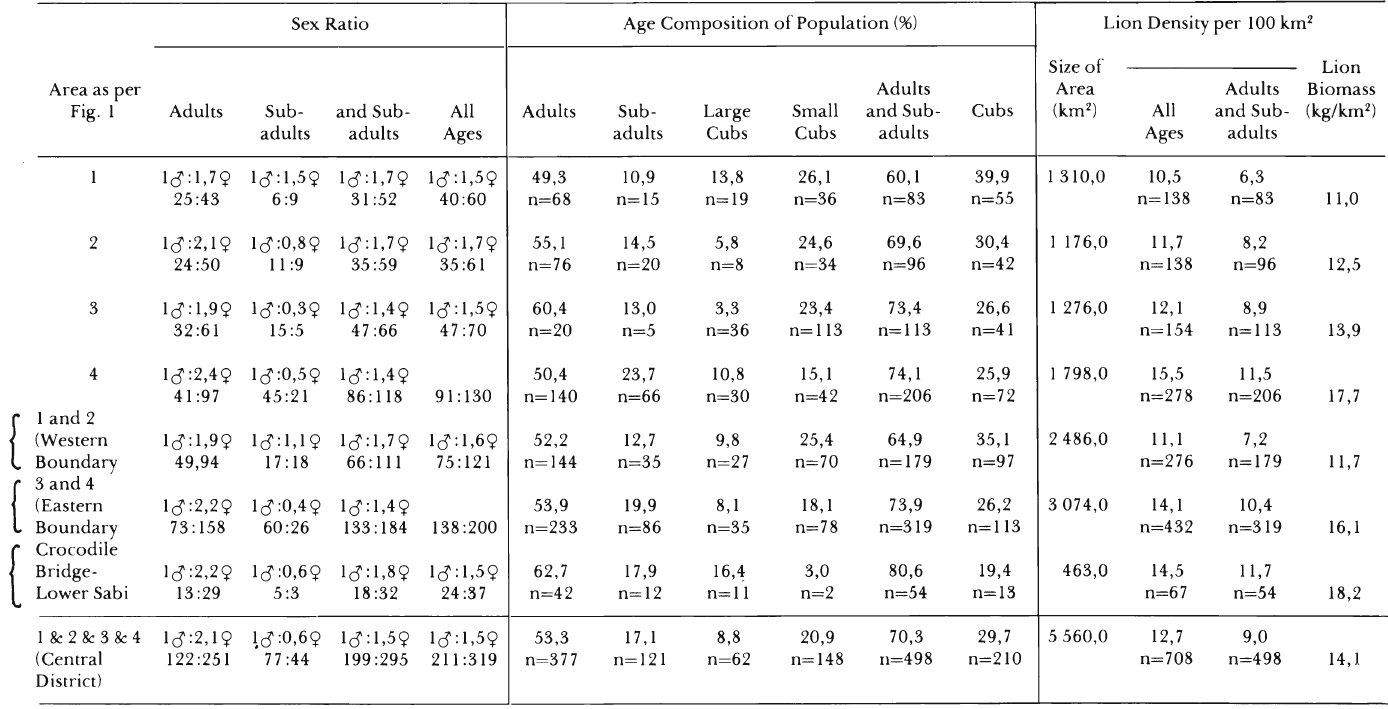
Population characteristic;, density and biomass for lions from the Central District and the Crocodile Bridge-Lower Sabi are of the Kruger National Park Sex Ratio Age Composition of Population (%) Lion Density per 100 km' Size of Lion